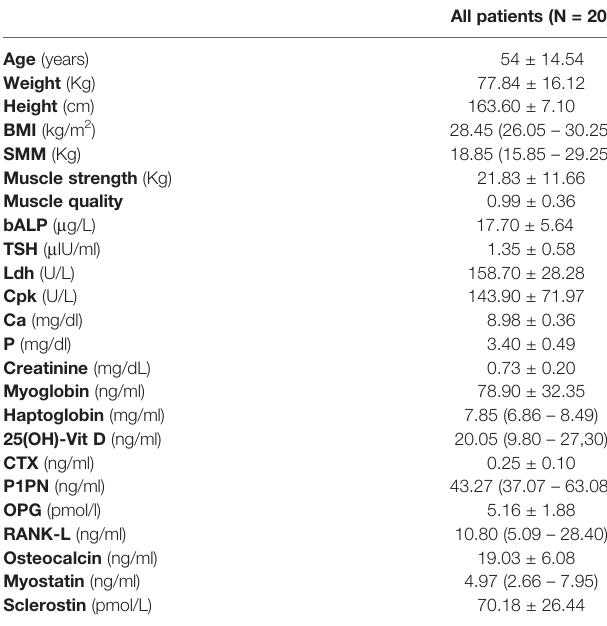
TABLE 1 | Demographic, anthropometric, skeletal muscle mass, and laboratory parameters of patients.